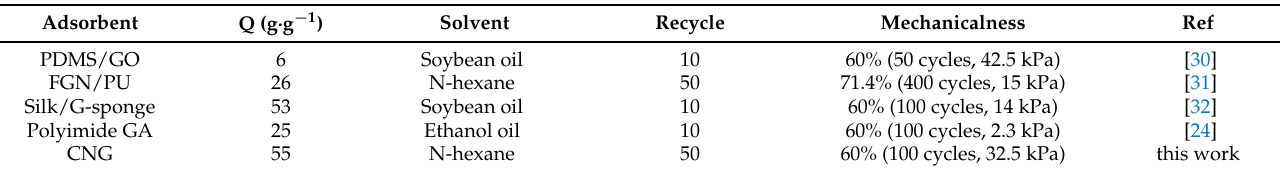
Table 1. Comparison of different oil adsorbents from past studies